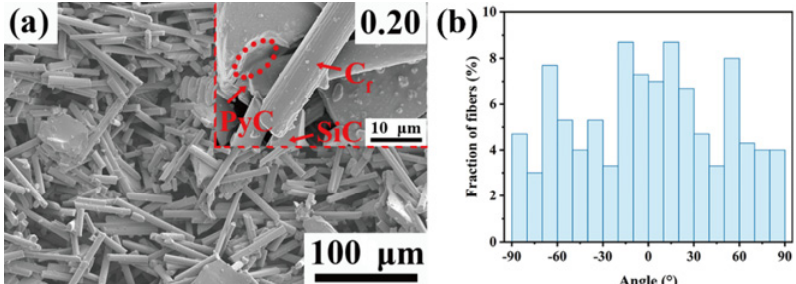
Fig. 6 (a) Representative morphology of C f /SiC/C green body (SiC:IM = 0.20); (b) C f orientation distribution corresponding to